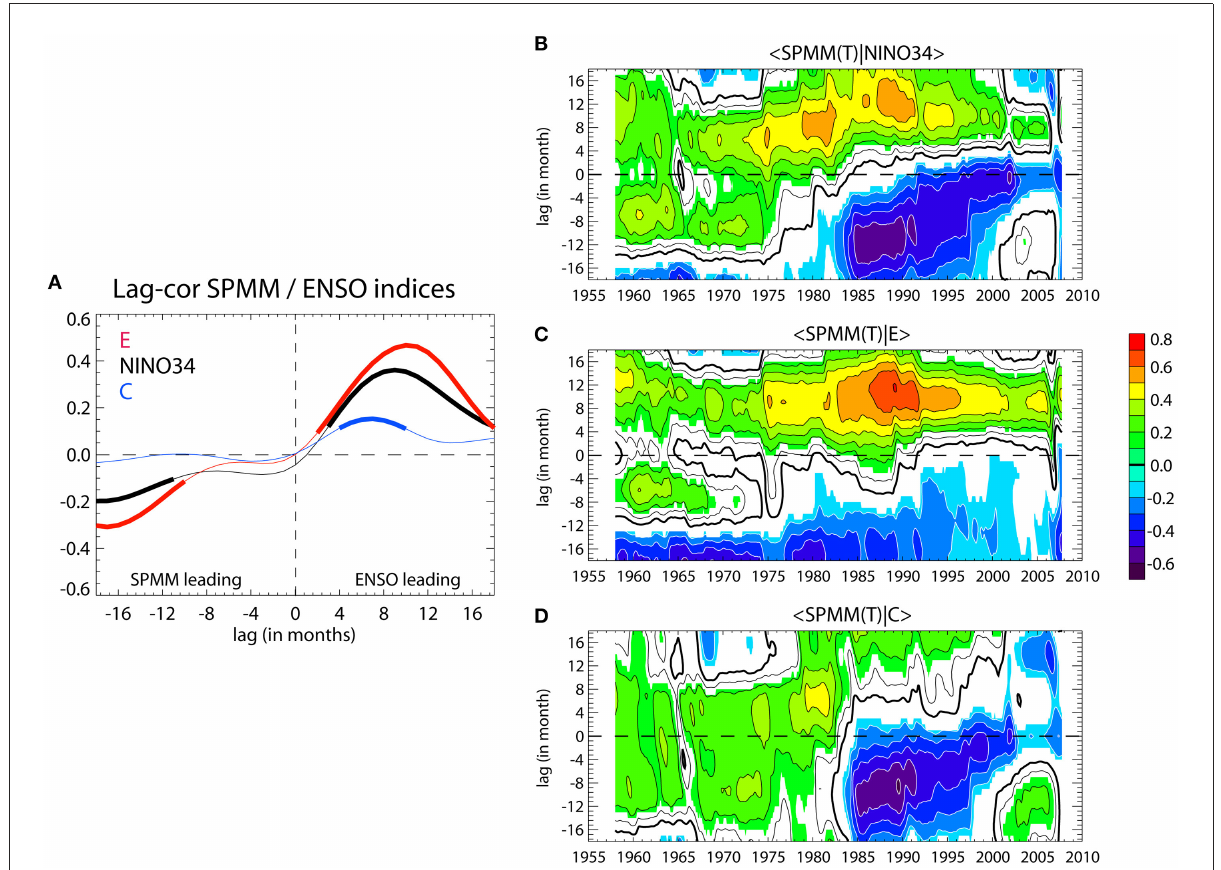
FIGURE2 (A) Lagged correlation analysis between the SPMM index and ENSO indices: The color code refers to the ENSO indices (black is NINO34, red is E and blue is C). The segments in thick line indicate when the correlation is statistically significant at the 99% level based on a Student’s t -test. Negative lags mean that the SPMM index leads the ENSO indices. (B–D) 21-year running mean correlation between the SPMM index and the ENSO indices [ (B) : NINO34, (C) : E, and (D): C]. Shading is for correlation values significant at the 95% level. Positive lags mean that the ENSO indices lead the SPMM